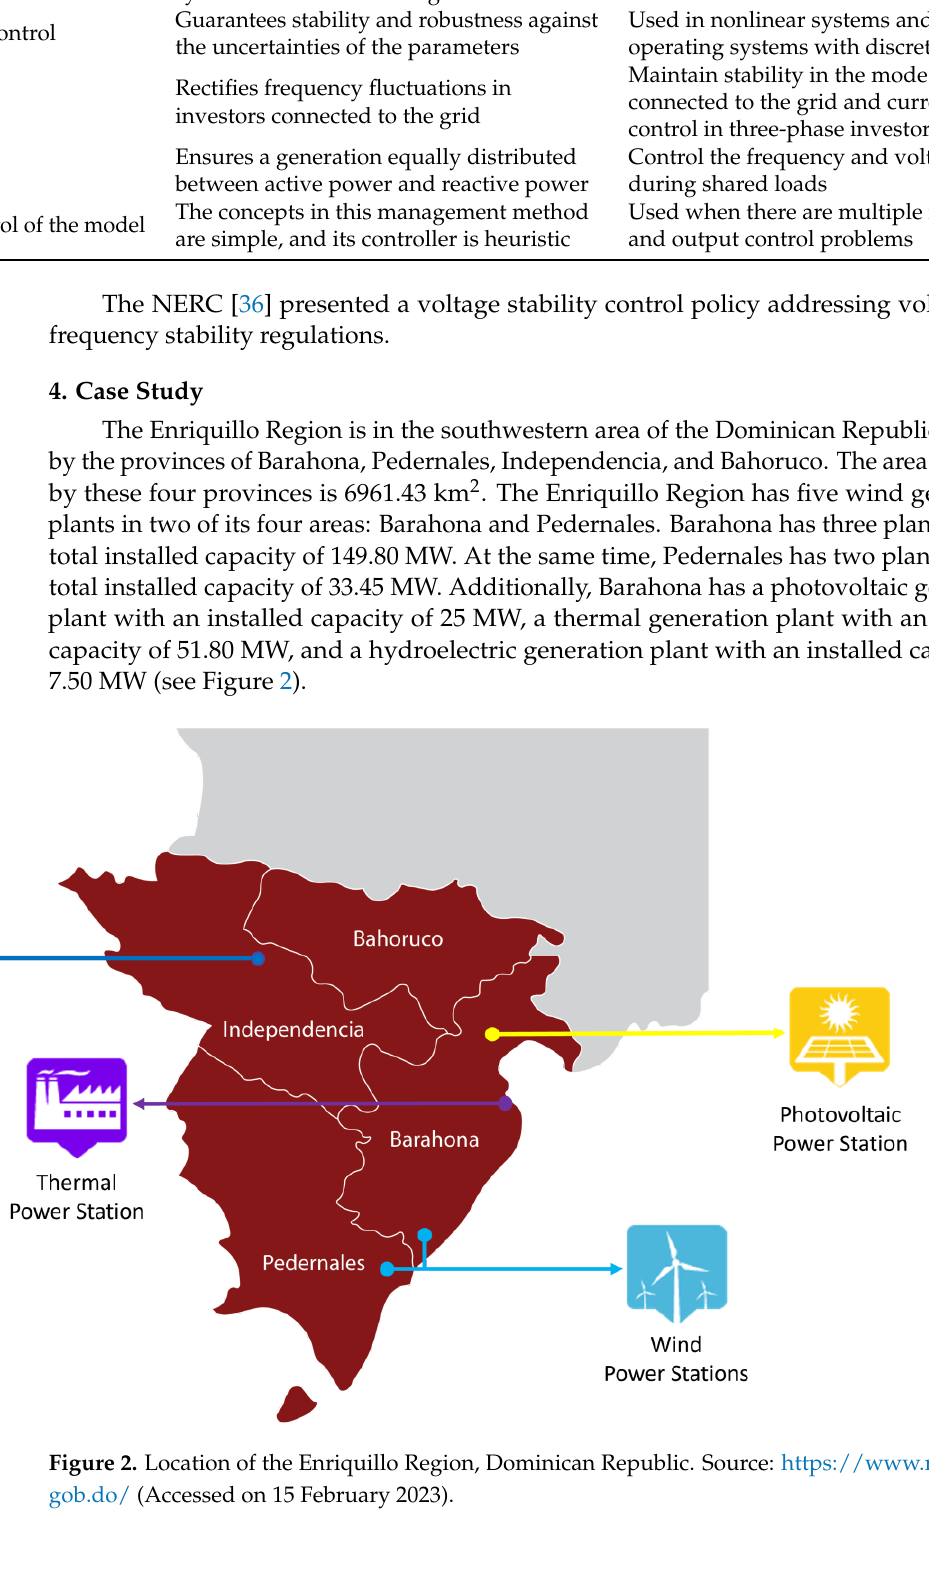
Table 4. Generation plants in the Enriquillo Region.